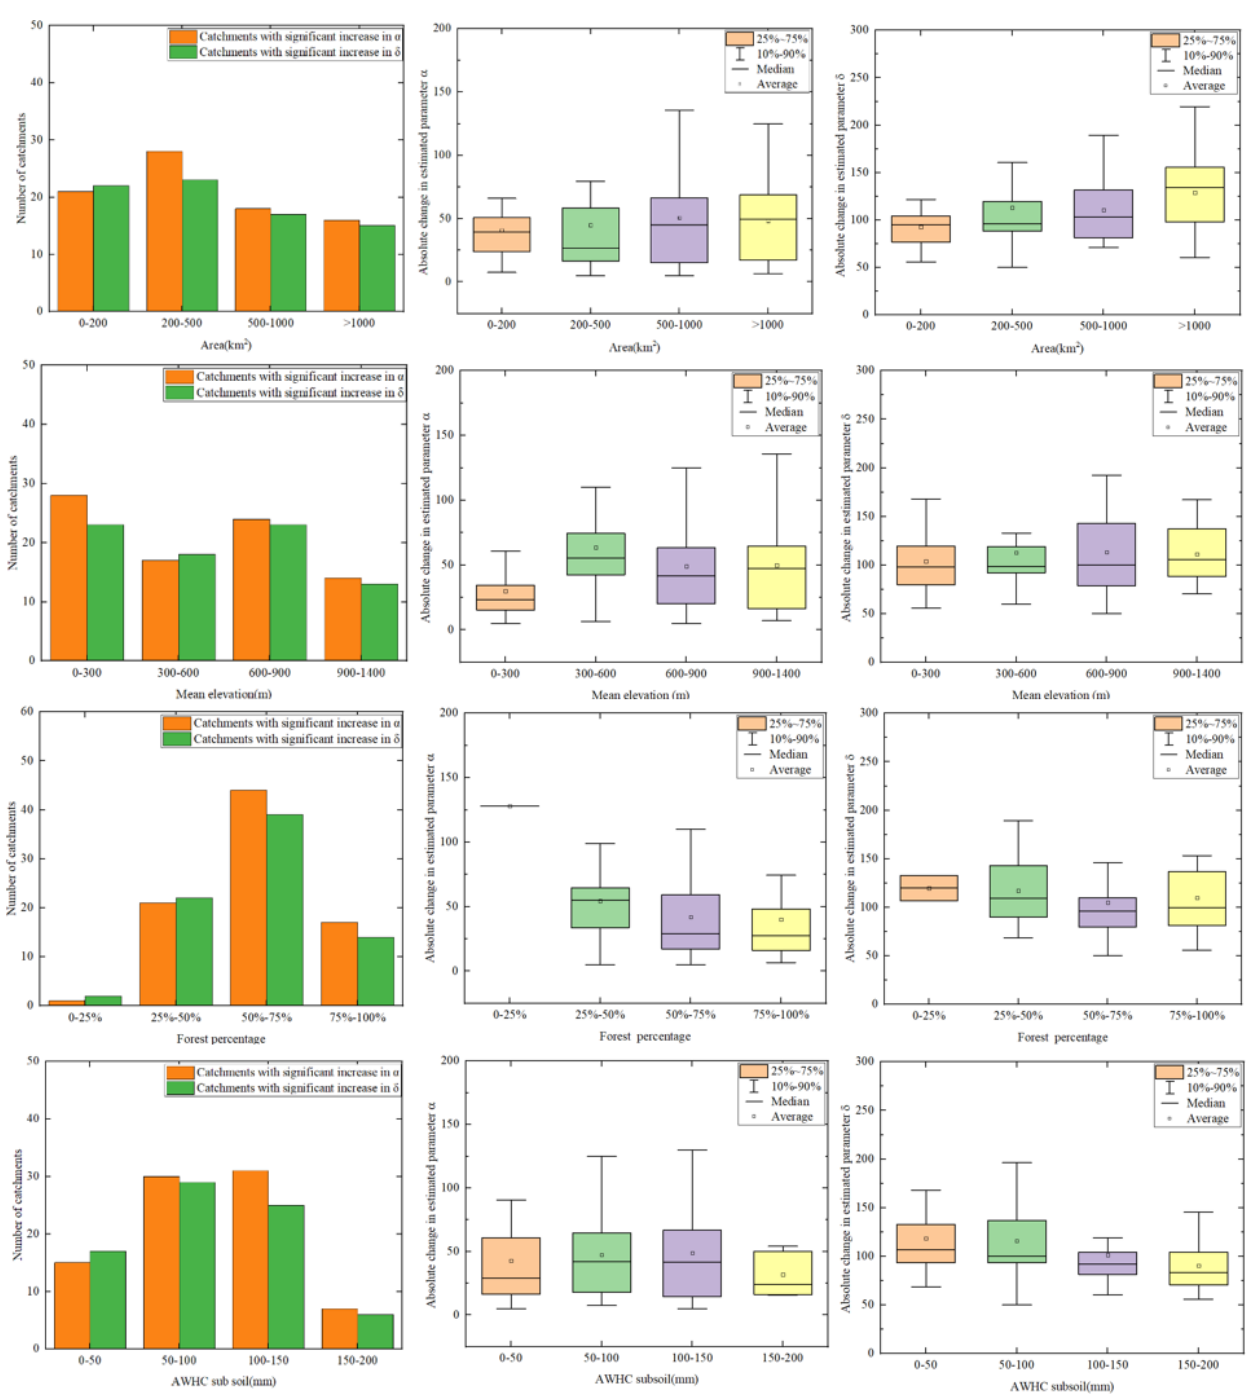
Figure 13. Trend analysis between the variation in the ACWSC and catchment properties.